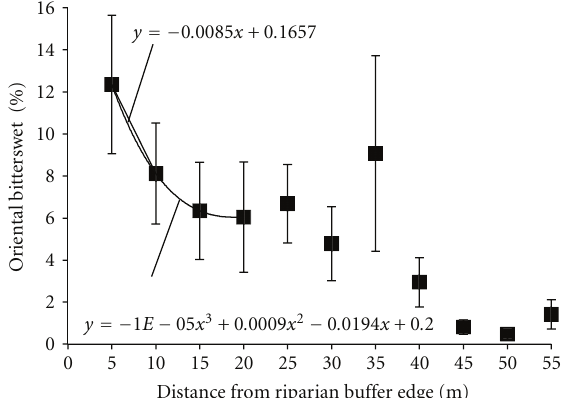
Figure 5: The prevalence of multiflora rose away from the edge of forested riparian bu ff ers in Delaware and Pennsylvania, 2007- 2008. Within-subject contrasts indicated a significant ( P < 0 . 10) decreasing linear trend through 10 m and a decreasing cubic trend through